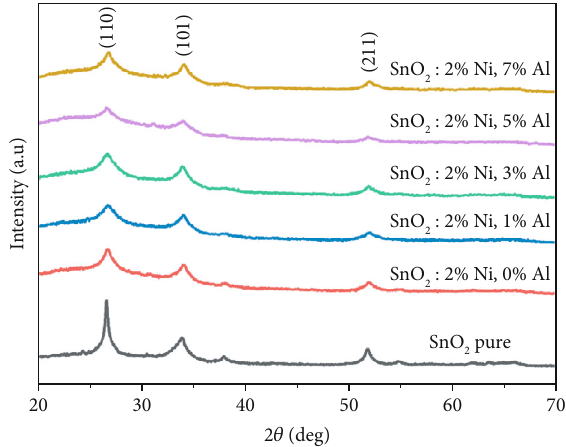
Figure 2: X-ray di ff raction patterns of Al-Ni-codoped SnO fi lms with various aluminum-doping concentrations (0%, 1%, 3%, 5%, and Figure 2. As revealed in Figure 2, the di ff raction peaks were observed at 2 θ = 26 : 71 ° , 34.01 ° , and 51.94 ° which corre- spond, respectively, to the reticular planes (110), (101), and (211). It is interesting to note that all peaks of X-ray di ff rac- tion have the same peaks as the undoped SnO prepared samples have the (110) di ff raction peak as the most intense one, indicating that the (110) peak is the preferential growth direction [45] and has the (101) and (211) minor dif- fraction peaks re fl ecting the polycrystallinity of the structure of the undoped layers, which is in good agreement with the data from the JCPDS reference fi le (N ° , 41-1445) which con- fi rm the tetragonal cassiterite (rutile) structure crystal of our fi lms [46]. The results explicate that Ni and Al incorporation does not change the tetragonal rutile-type structure of SnO